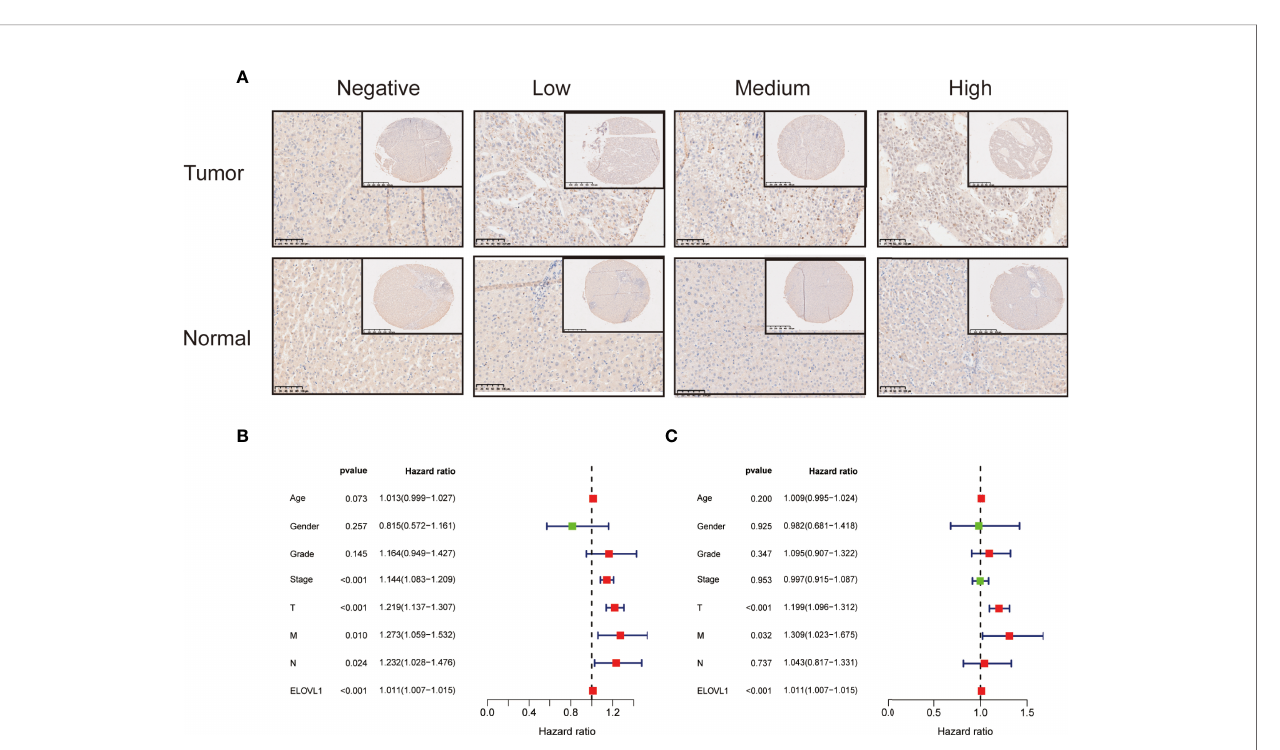
FIGURE 5 | The immunohistochemical staining of ELOVL1 expression and Cox analysis of ELOVL1. (A) The immunohistochemical staining of ELOVL1 expression in HCC and normal adjacent liver tissues. (B, C) Univariate and multivariate Cox regression analysis of ELOVL1 and clinicopathologic variables of patients with HCC from TCGA